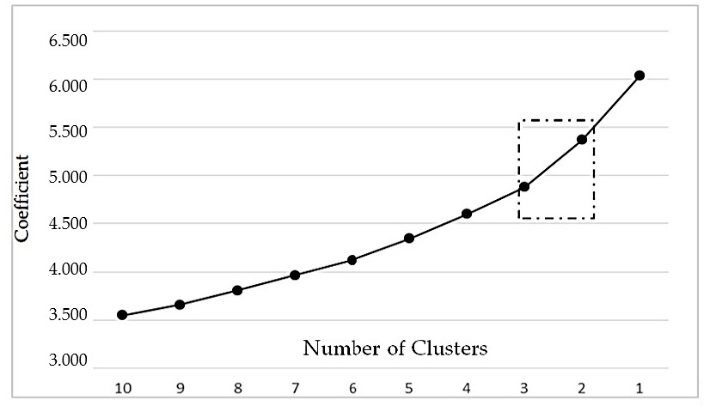
ffi cients from the agglomeration Figure 1. Analysis of the coefficients from the agglomeration schedule Figure 1. Analysis of the coe